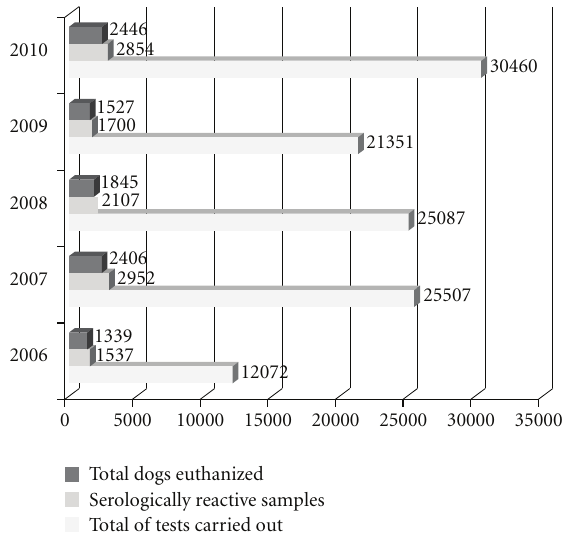
Figure 7: Total number of canine serological tests for Leishmania sp performed, total of positive samples, and total of dogs euthanized in SD Venda Nova from 2006 to 2010.